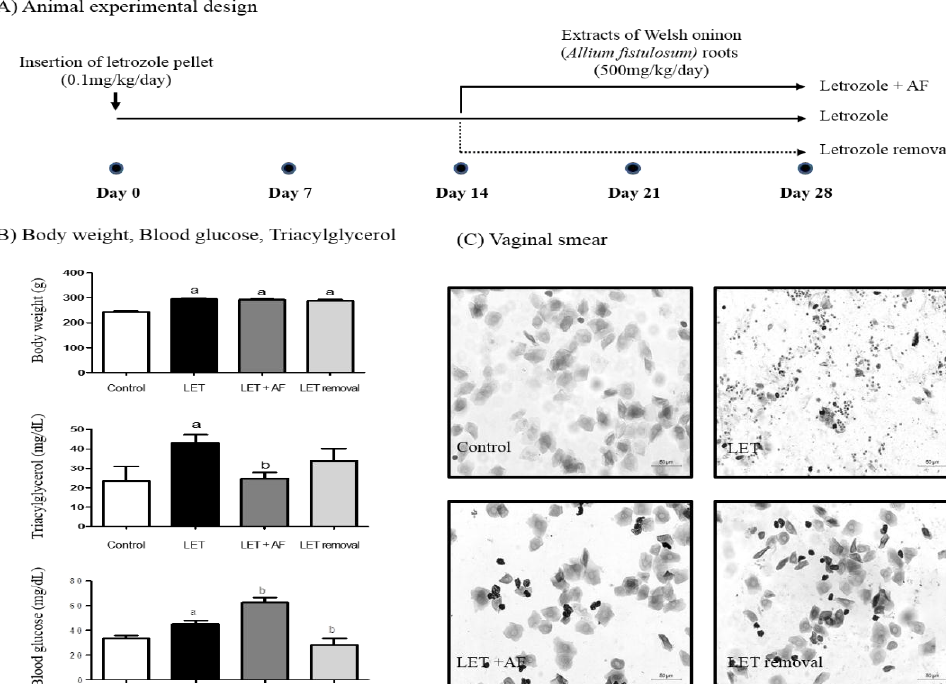
Figure 2. Effect of A. fistulosum root extract on physiological changes. ( A ) Animal experimental design. For polycystic ovarian syndrome (PCOS) experiments, a letrozole pellet was imbedded into a six-week-old female rat subcutaneously. On day 14, 2 weeks, A. fistulosum extract was treated orally at 500 mg/kg/day for 2 weeks (until day 28) to the LET + AF group, and in the LET removal group, the letrozole pellet was removed at day 14. ( B ) Body weight, triacylglycerol and blood glucose measured at day 28; n = 6–10, a p < 0.05 vs. Control group, b p < 0.05 vs. LET group. ( C ) Picture of the vaginal